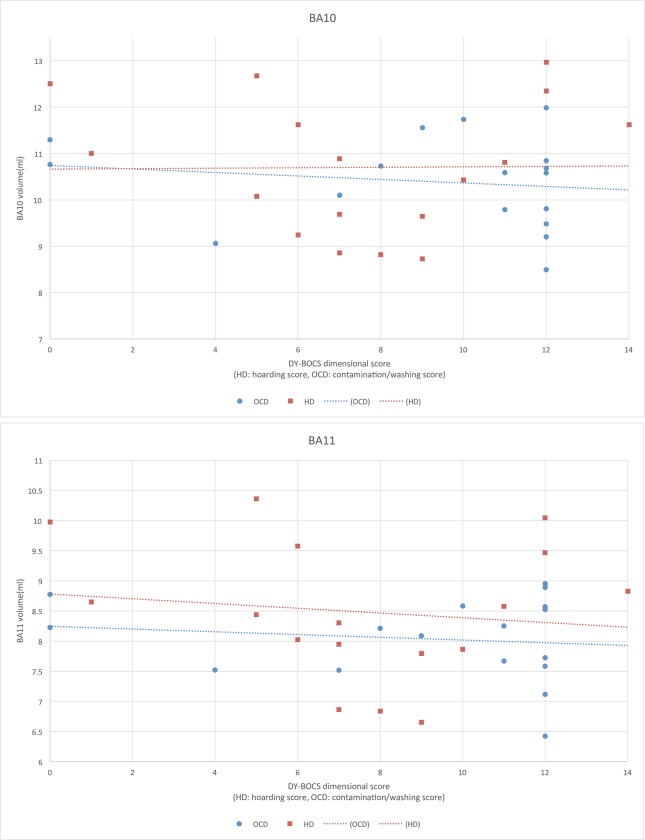
The results of correlation analysis.No significant correlation between the DY-BOCS dimensional score (HD: hoarding score, OCD: contamination/washing score) and GM volume was observed in either the HD or OCD group.